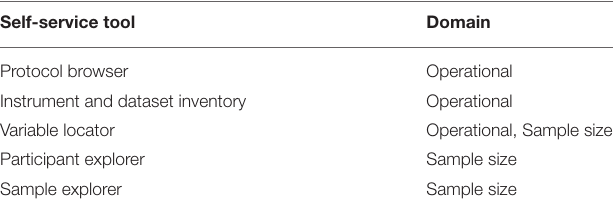
TABLE 4 | NCS archive self-service tools and domains of